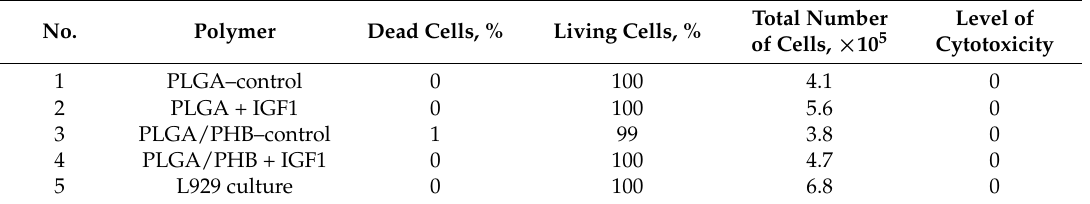
Table 6. Number of cells and level of cytotoxicity after 72 h of incubation—direct method. No.